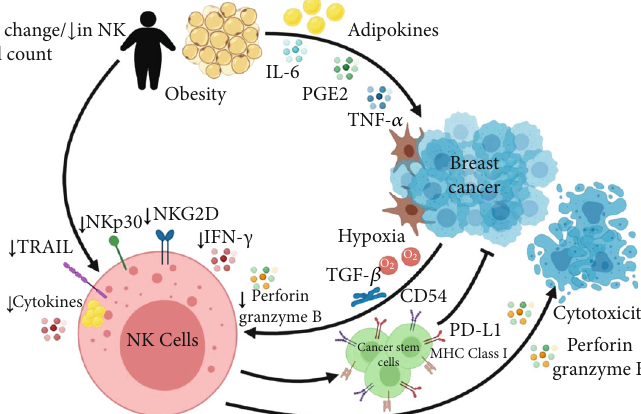
Figure 1: Triad of obesity, natural killer cells, and breast cancer. Typically, natural killer (NK) cells release perforin and granzyme B, molecules that cause cytotoxicity and induce apoptosis of breast cancer (BC) cells. Additionally, NK cells stimulate the expression of CD54, PD-L1, and MHC class I molecules on cancer stem cells, which inhibit the metastasis and proliferation of breast cancer cells. In turn, hypoxic environment of breast cancer cells and secreted TGF- β by stromal cells in the tumor microenvironment (TME) cause a reduction in the activating receptors (NKG2D and NKp30) as well as the NK cell function: IFN- γ production and cytotoxicity via perforin and granzyme B release. Similarly, adipose tissue causes a reduction in TRAIL, NKp30, and NKG2D expression in obese patients. Lipid droplet accumulation in NK cells leads to a reduction in cytokine release such as IFN- γ . Controversial data were reported regarding the count and status of NK cells in obese individuals. On the other arm, adipose tissue secretes IL-6, PGE2, TNF- α , and adipokines such as leptin which trigger the proliferation of breast cancer cells via the MAPK and mTOR